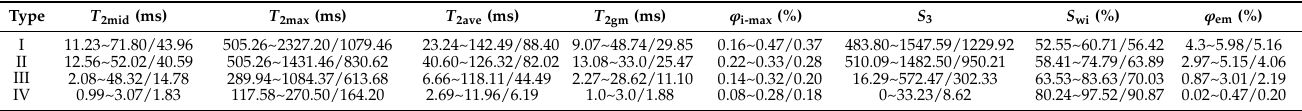
Table 2. Statistics of the NMR T 2 spectral parameters for four types of pore structures in the E s4 sandstone reservoirs.